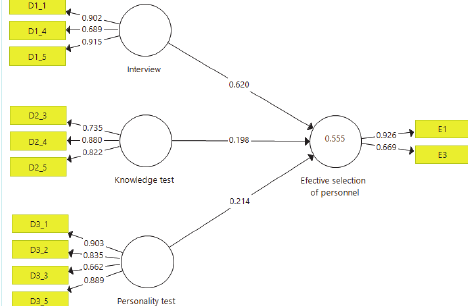
Fig. 2. Results of the hypothetical model with structural equations